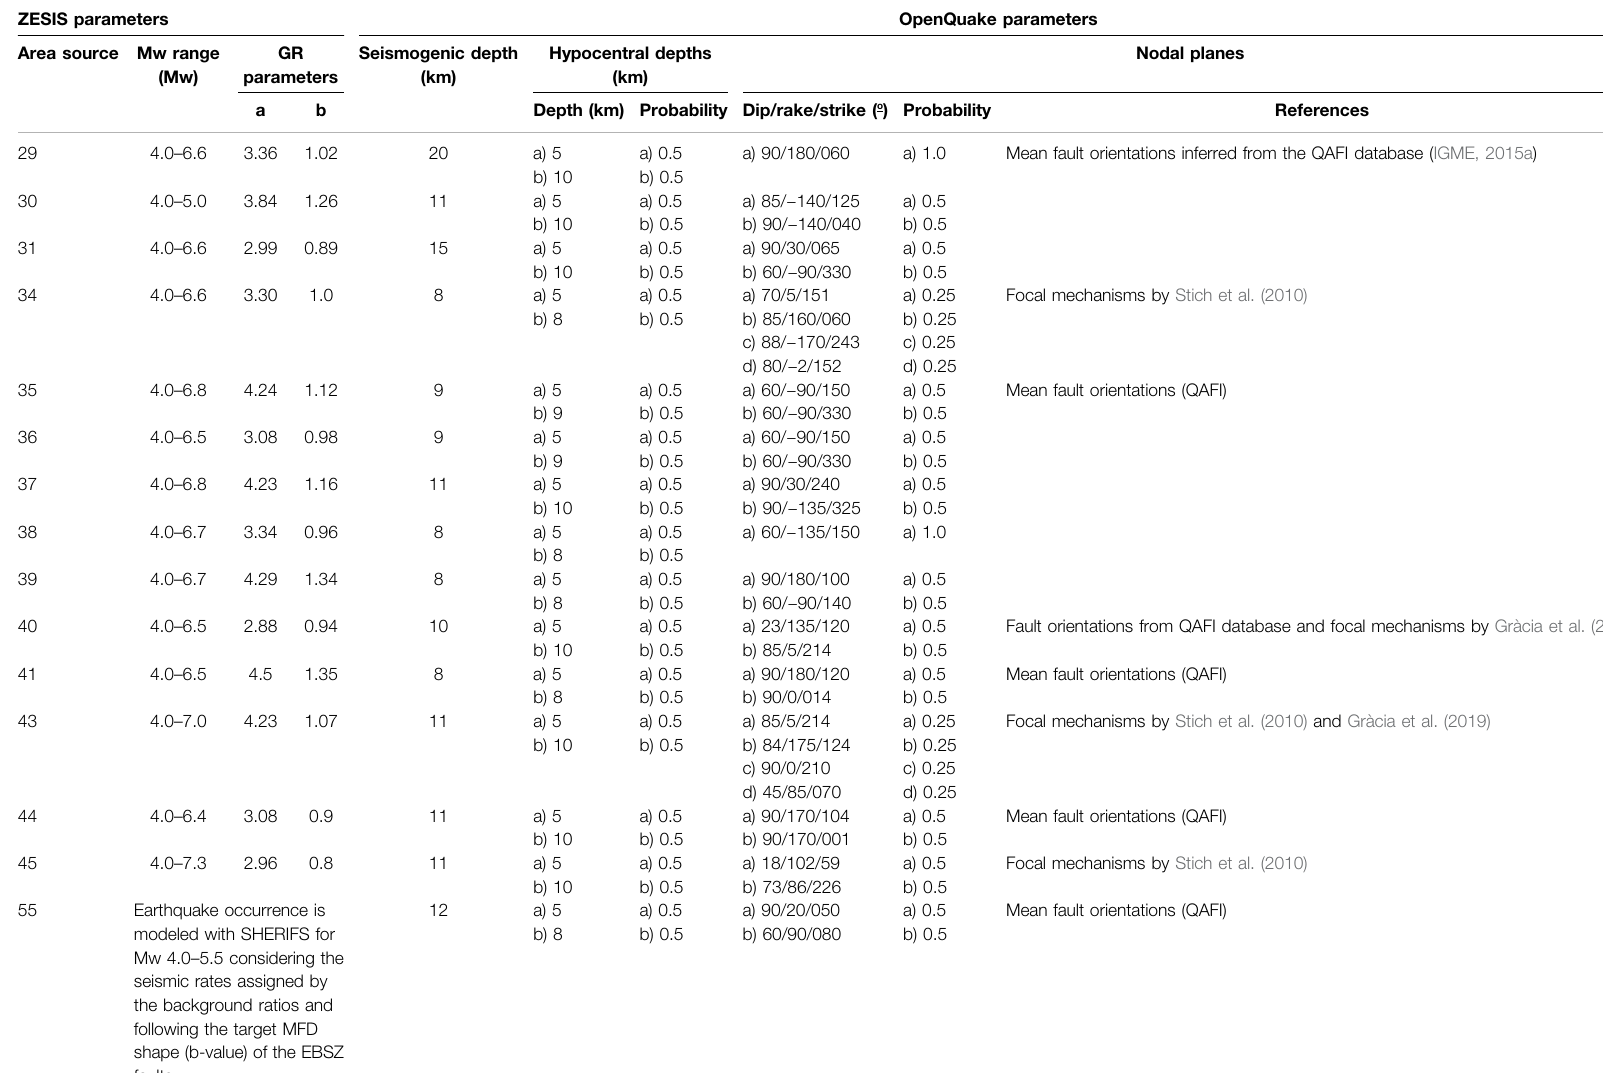
TABLE 3 | Parameters of the area sources used for the area source model in this study. Mmin, Mmax (Mw range), a and b-values of the GR distribution are extracted from the ZESIS area source model (IGME, 2015b; García-Mayordomo,2015).OpenQuakerequiredparameterssuchasnodalplanesareinferredfrommainfaultorientationsoftheQAFIv.3.Database(IGME,2015a;García-Mayordomoetal.,2017)orfocalmechanisms of the studies indicated in the table. Seismogenic depths are based on fault data compiled in the QAFI database. ZESIS